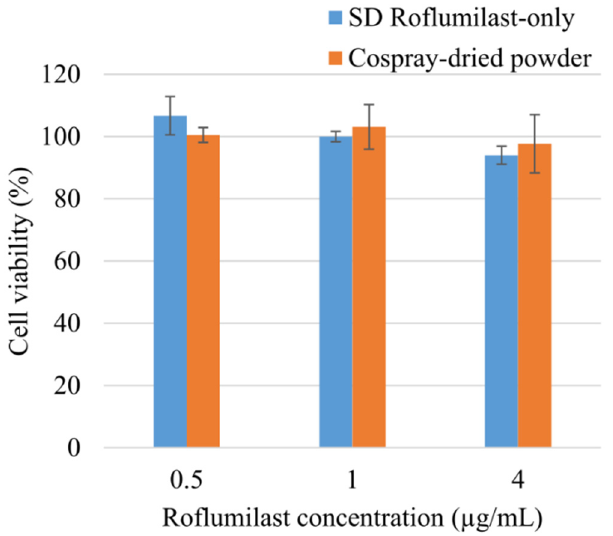
Figure 9. Cytotoxicity studies on A549 cells using roflumilast-only and cospray-dried powder (error bars are means ± standard deviations, n = 3).